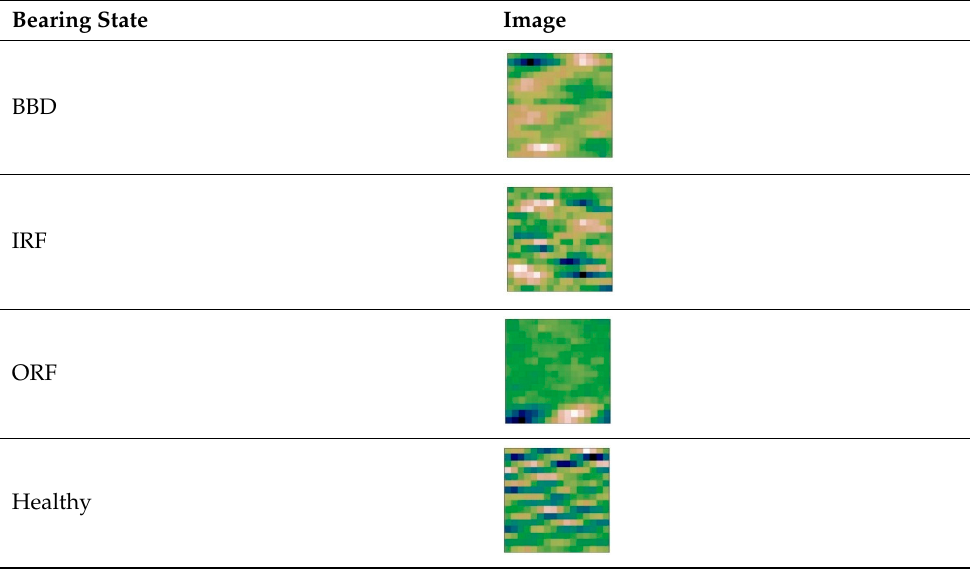
Figure 6. Test setup for the analysis comprising 2 hp motor. Table 1. Samples of images created for various states of the bearing.